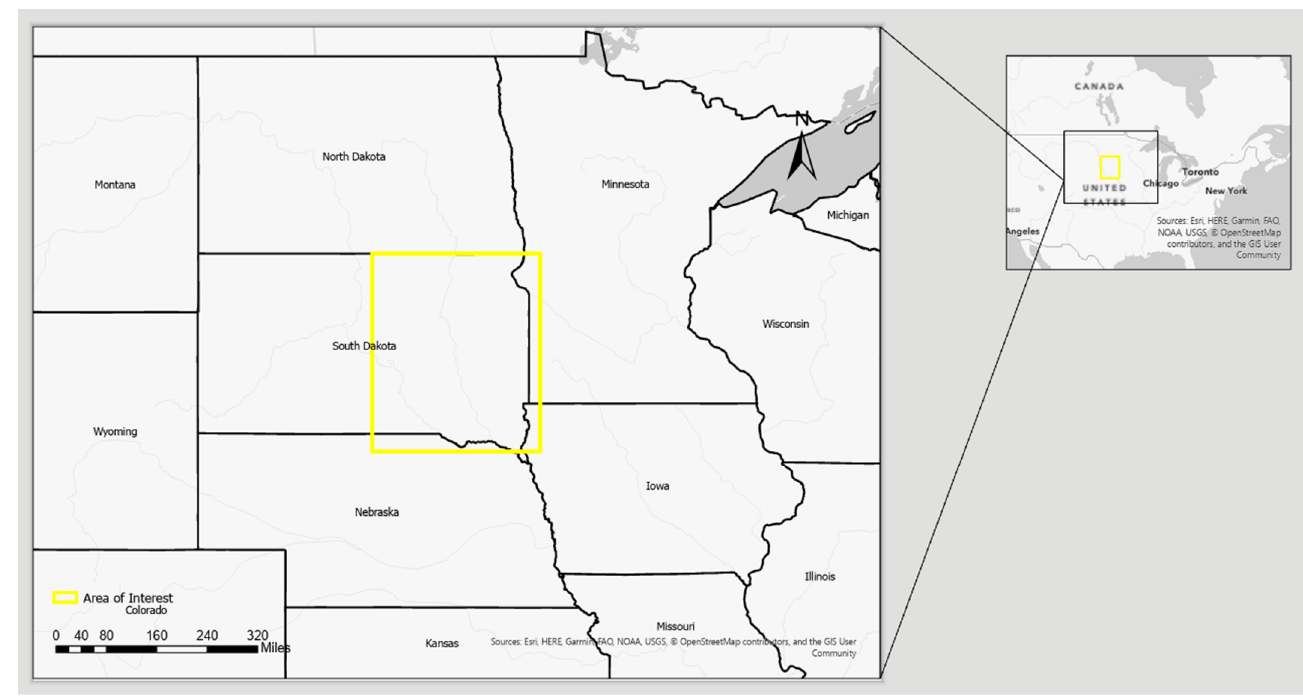
Figure 1. The yellow rectangle indicates the study area which covers the eastern half of South Dakota. Table 1. Summary of the data